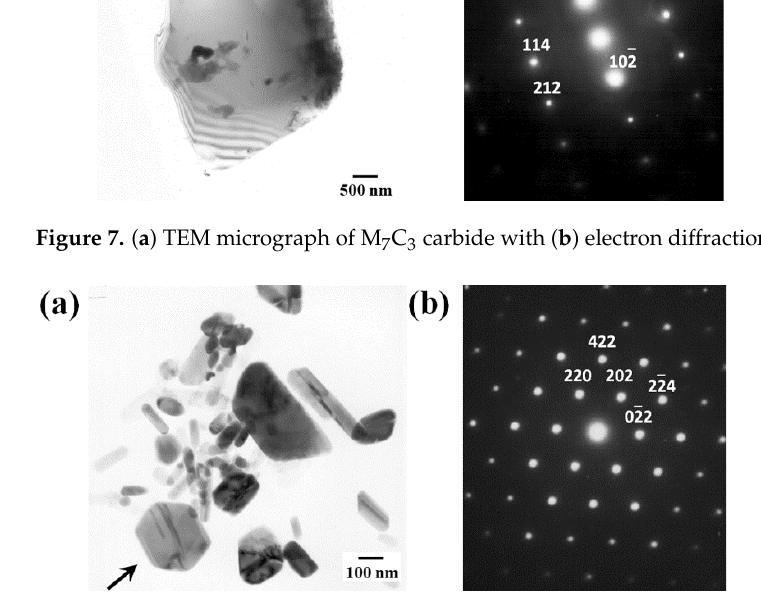
(cid:2) (cid:3) 261